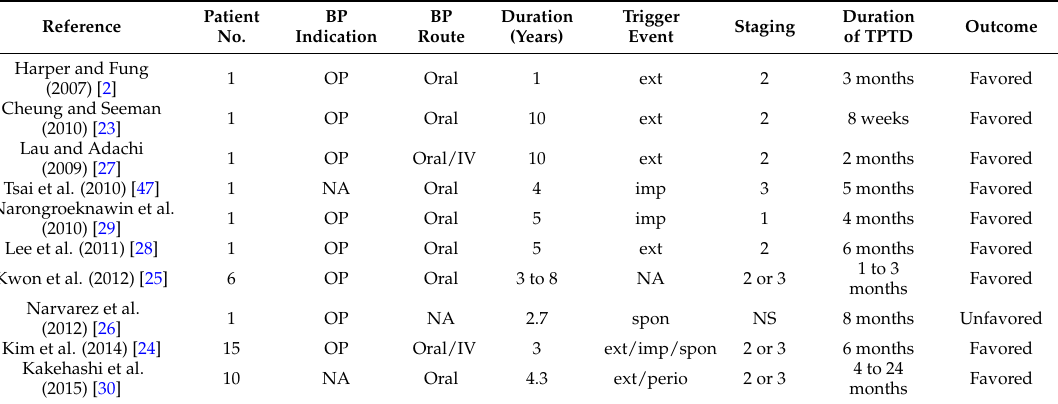
Table 1. Human studies on teriparatide application for medication-related osteonecrosis of the jaws (MRONJ)